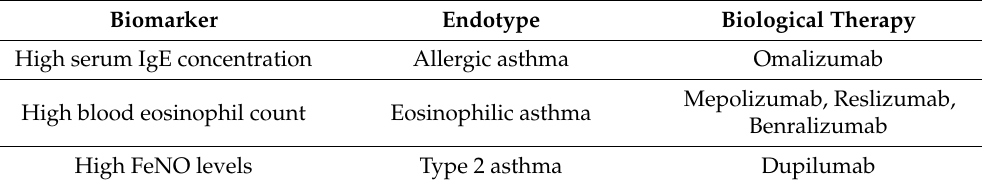
Table 1. Biomarker-guided choice of biological treatments for severe